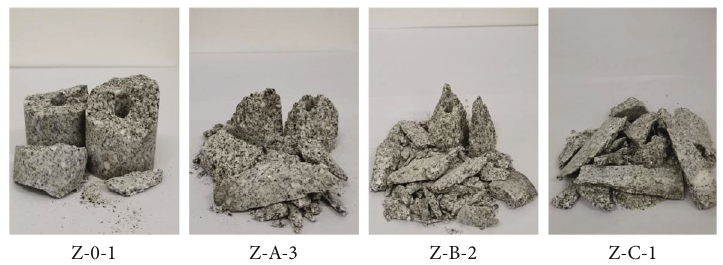
Figure 13: Di ff erent axial prestress failure